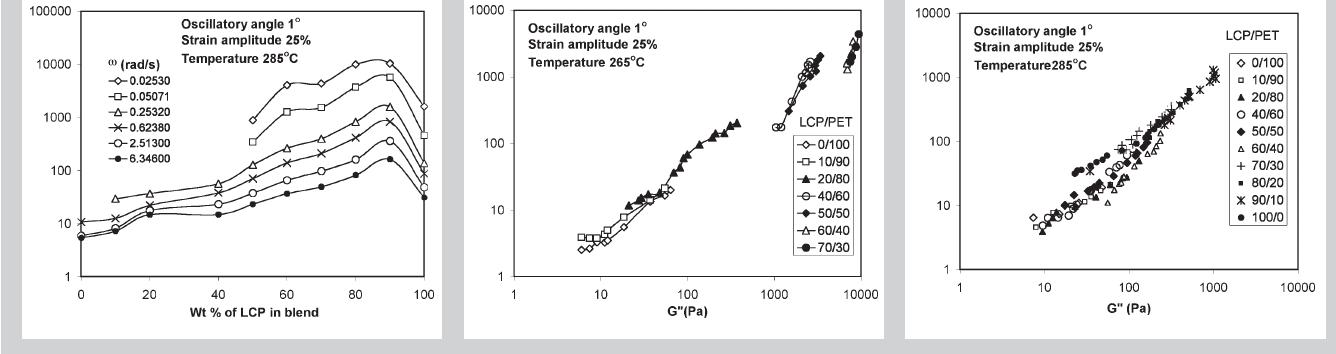
Figure 10 (left): Dynamic viscosity and the composition of blend at 285°C corresponding to dif- ferent shear rates. Figure 11 (middle): Moduli G’ and G’’ at 265°C. Figure 12 (below): Moduli G’ and G’’ at